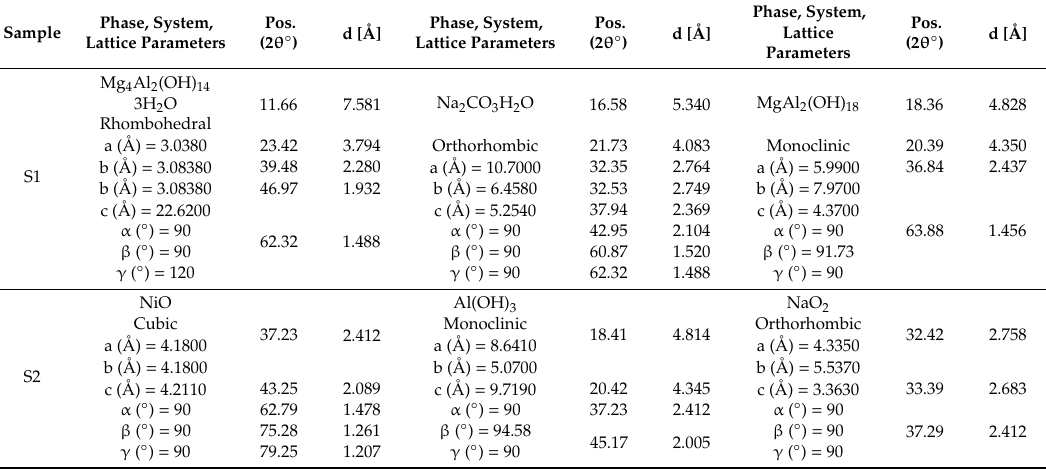
Figure 3. XRD patterns for LDHs before and after Mn 2+ adsorption.